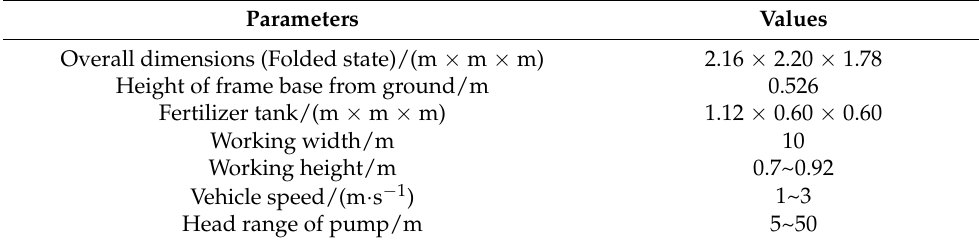
Table 1. Main structure and performance parameters of liquid fertilizer sprayer.